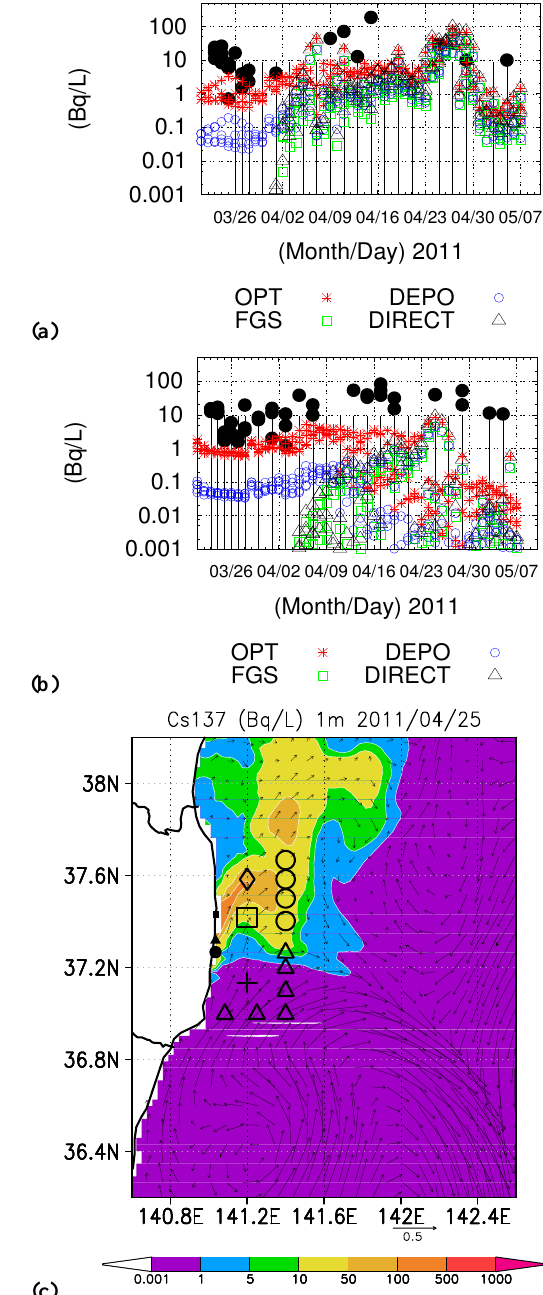
Fig. 12. (a) Time sequences of 137 Cs at 1m depth on the points northeast of FNPP, denoted by open circles shown in (c) . Closed circles: MEXT observation (see Table 1). Asterisks: JCOPE-T-2-C-E. Open squares: JCOPE-T-2-C. Open circles: the sensitivity experiment for the atmospheric deposition. Open triangles: the sensitivity experiment for the direct release. Vertical bars: measurements reporting 137 Cs activities below the detection limit, 10BqL − 1 . (b) As in (a) , except for the points southeast of FNPP, indi- cated by open triangles shown in (c) . (c) Daily mean 137 Cs concentration (in BqL − 1 ) on 25 April 2011 at 1m depth (shaded) simulated by the JCOPE-T-2-C-E case. Vec- tors indicate the daily mean current at 1m depth. The position of FNPP is denoted by a closed square. The TEPCO monitoring points are indicated by a closed triangle (Fukushima Daini nuclear power plant), a closed circle (the Iwasawa Coast), an open diamond (15km off Minamisoma), an open square (15km off FNPP), and a plus sign (15km off Hirono). The MEXT monitoring points are indicated by open circles and